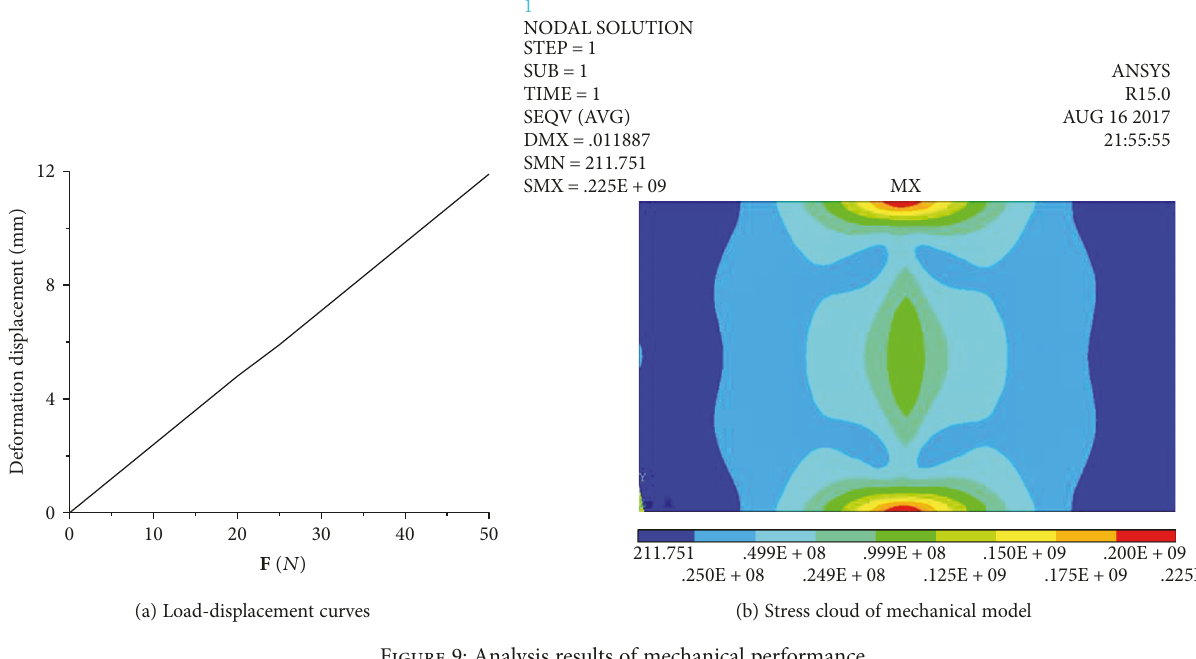
Figure 9: Analysis results of mechanical performance.